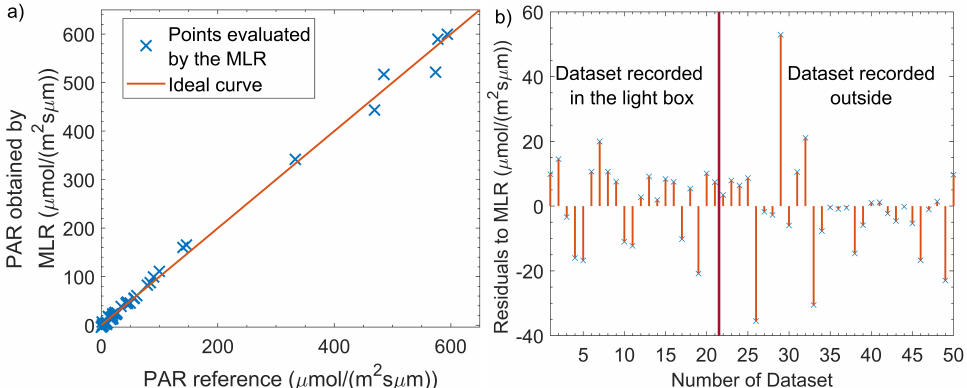
Figure 5. ( a ) Distribution of the obtained PAR via the LI-190 reference and predicted values of the MLR using data from the AS7341. The recorded data sets are over-represented at low light conditions. ( b ) Residuals of the MLR for each data